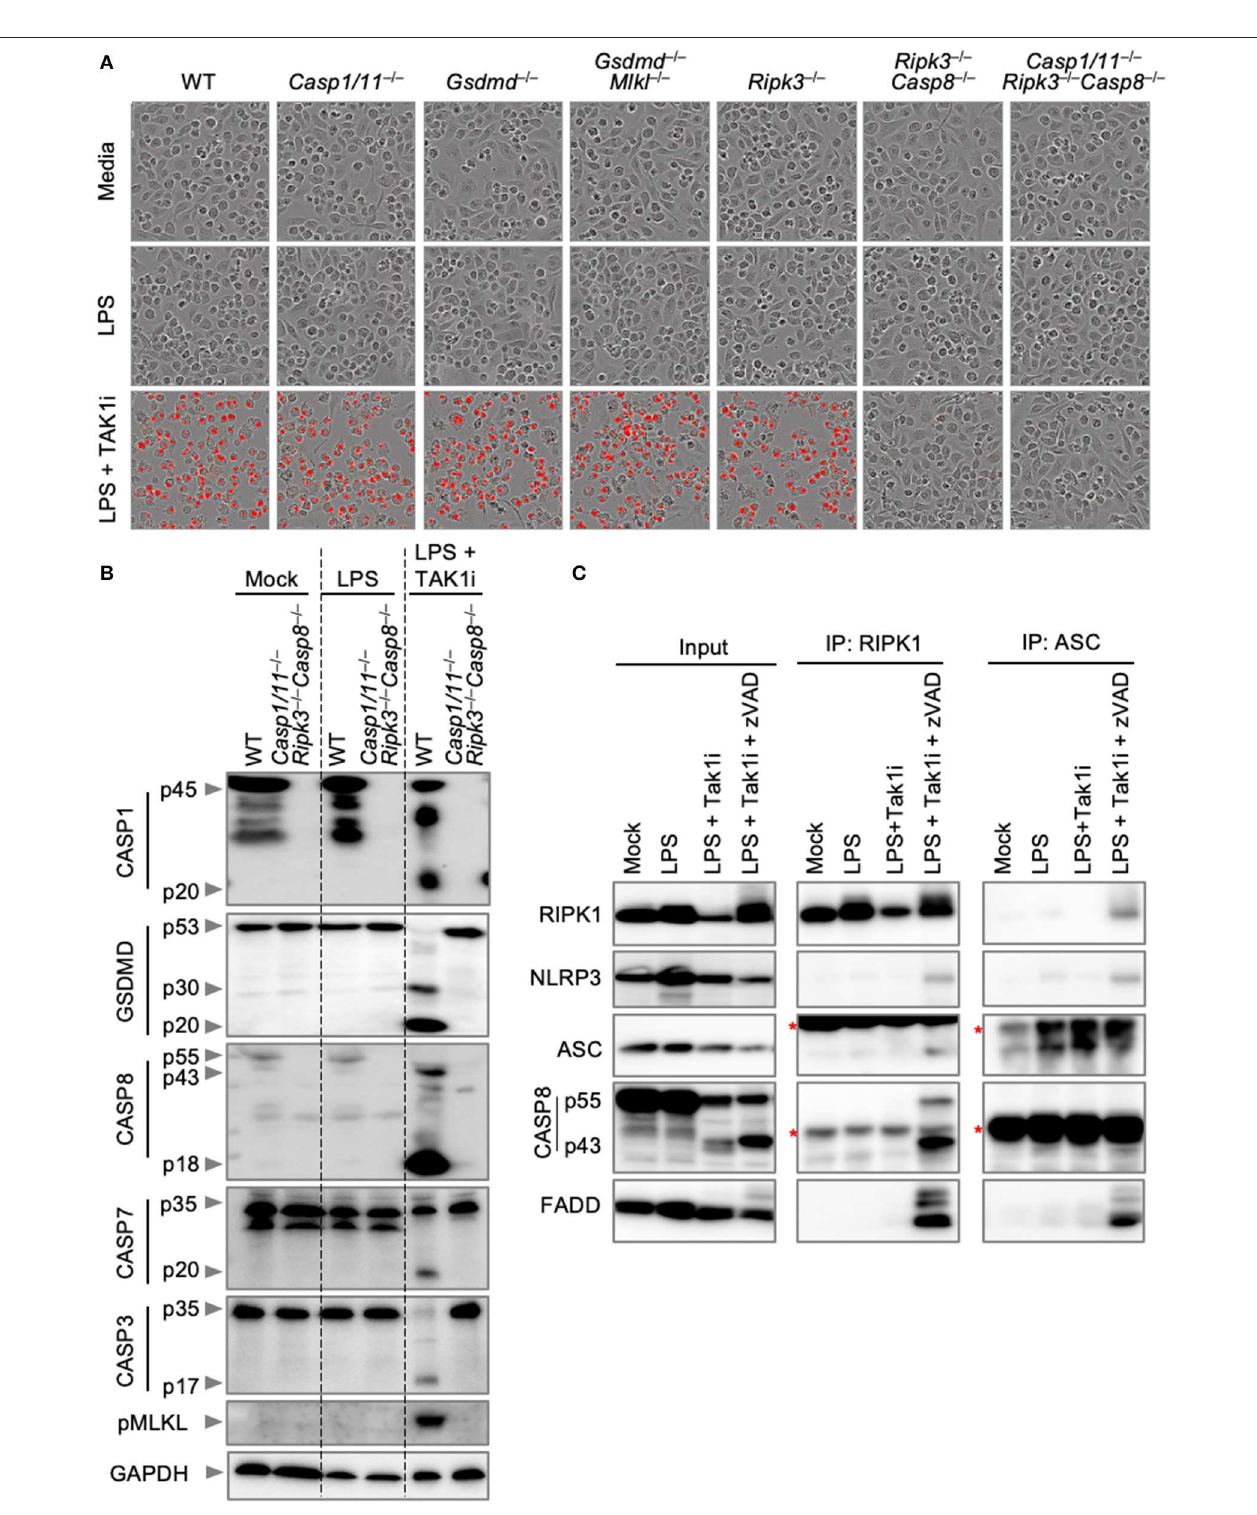
FIGURE 4 | Inhibition of TAK1 promotes PANoptosis and PANoptosome formation. (A) Representative cell death images of BMDMs lacking different components of pyroptosis, apoptosis, or necroptosis after LPS priming and inhibition of TAK1. (B) Western blot analysis of PANoptosis activation after LPS priming and TAK1 inhibition. (C) Co-immunoprecipitation of PANoptosome components from primary BMDMs after TAK1 and caspase inhibition. Red asterisks denote a non-specific band.